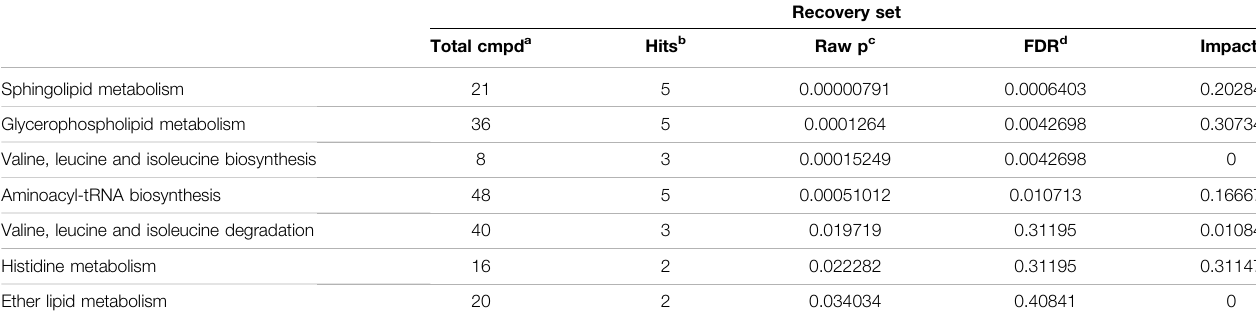
TABLE 3 | Pathway analysis showed that metabolic pathways signi fi cantly altered in COPD patients against Controls in Discovery